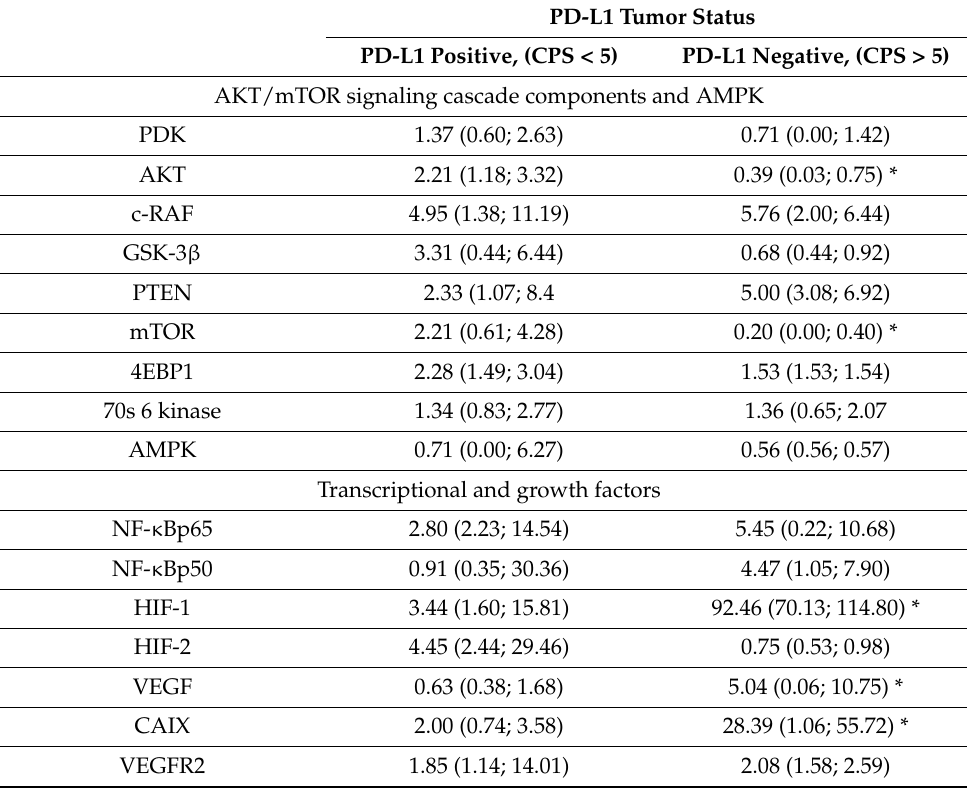
Table 6. Molecular markers in gastric cancers depending on the PD-L1 status after